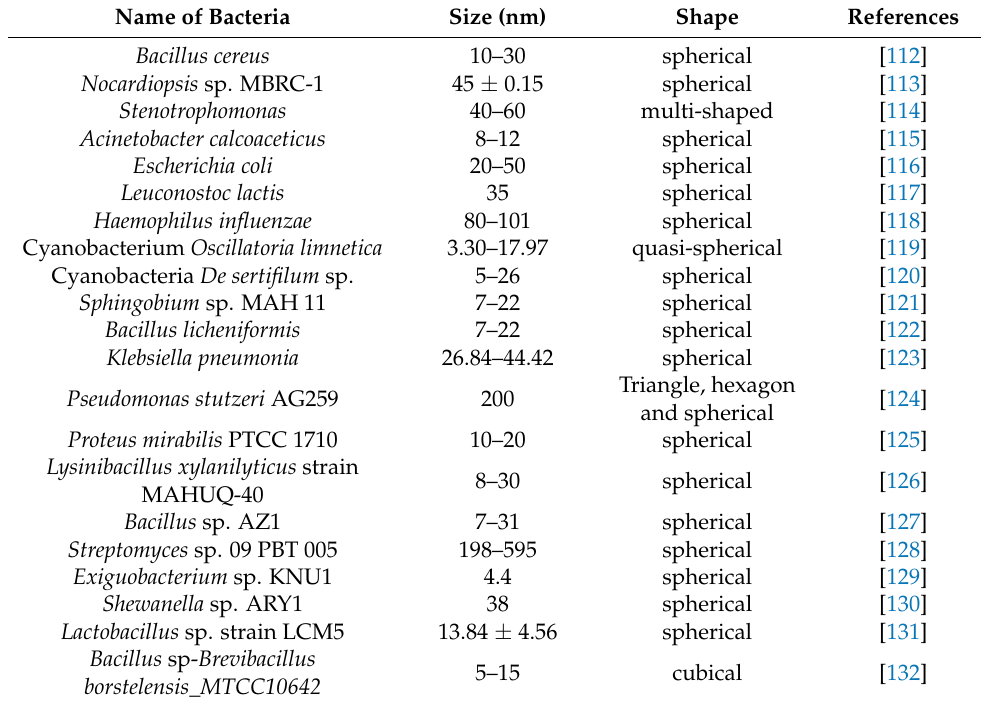
Table 1. Reported size and shape of AgNPs synthesized by